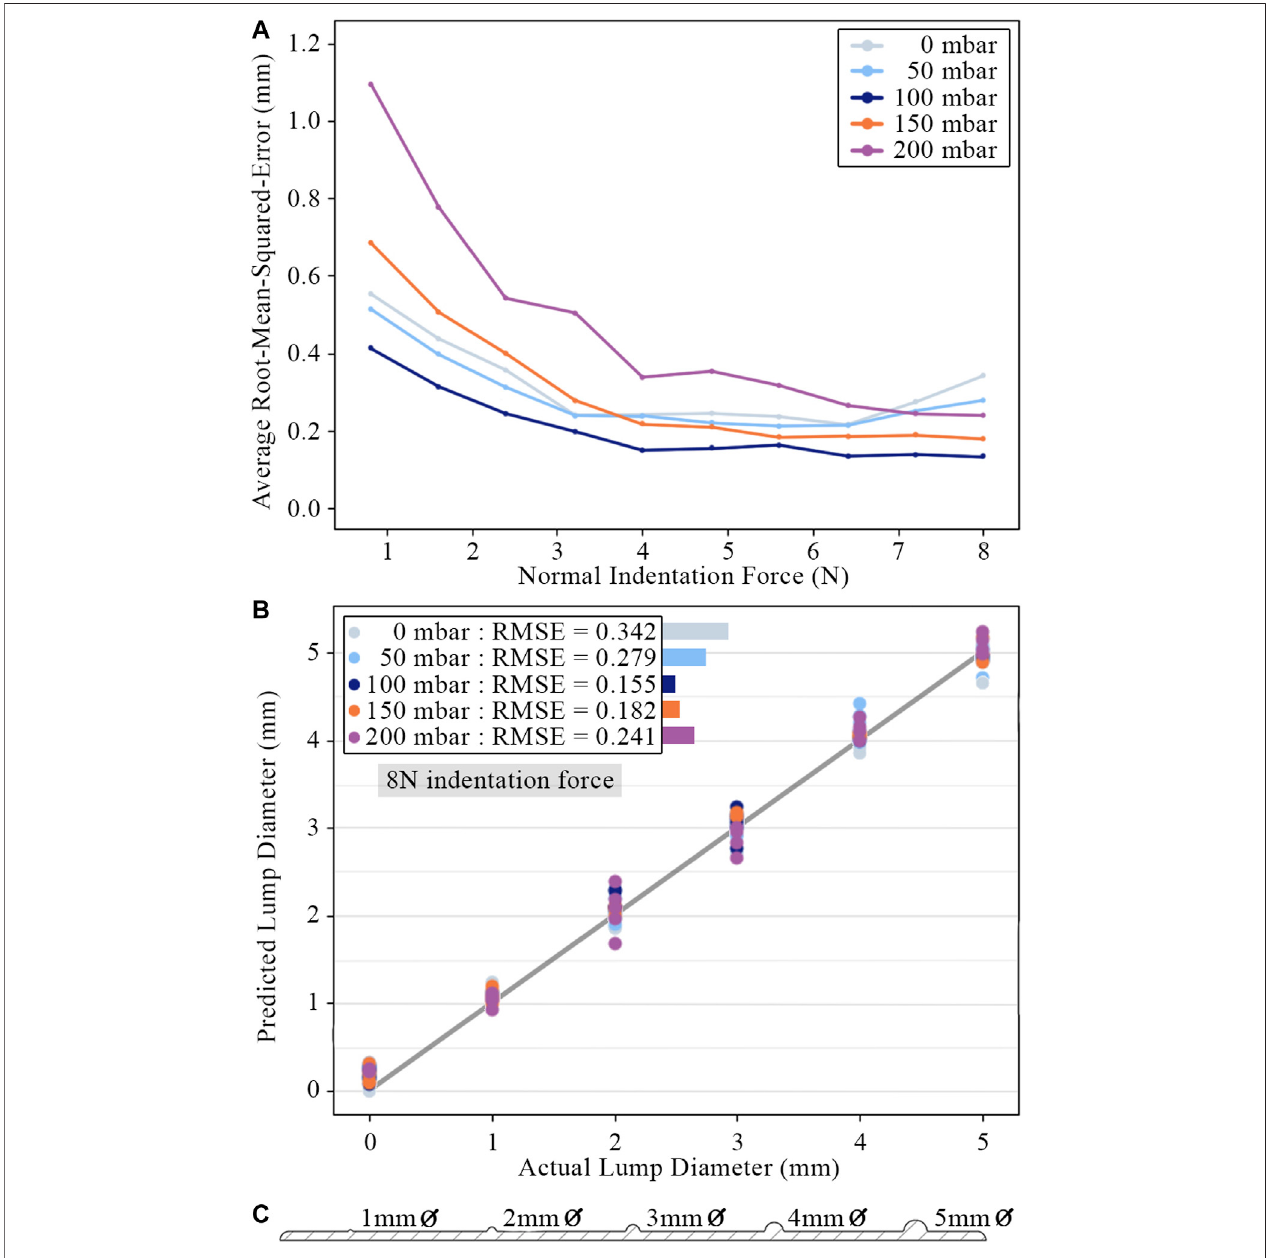
FIGURE 11 | (A) Root-mean-square-error of lump size predictions for different internal pressures across a range of indentation force. Points plotted for each pressure and force are average values across all tests. (B) Predicted lump diameters for an indentation force of 8 N . Each test is plotted as an individual point. (C) 3D printed lump test slab with hemispherical surface lumps varying in diameter from to 5 mm